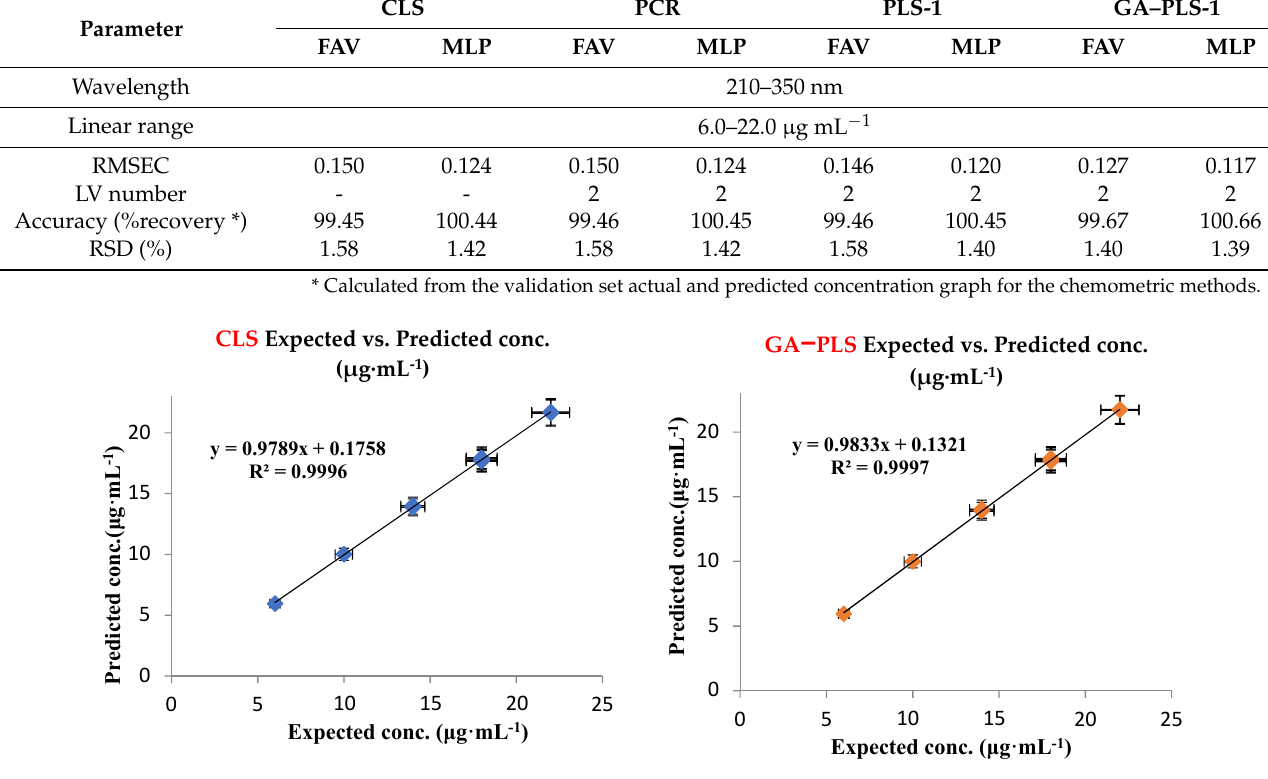
Figure 4. Actual against predicted concentration plots of FAV for CLS and GA–PLS models. Table 3. Validation set results for the four developed chemometric methods.